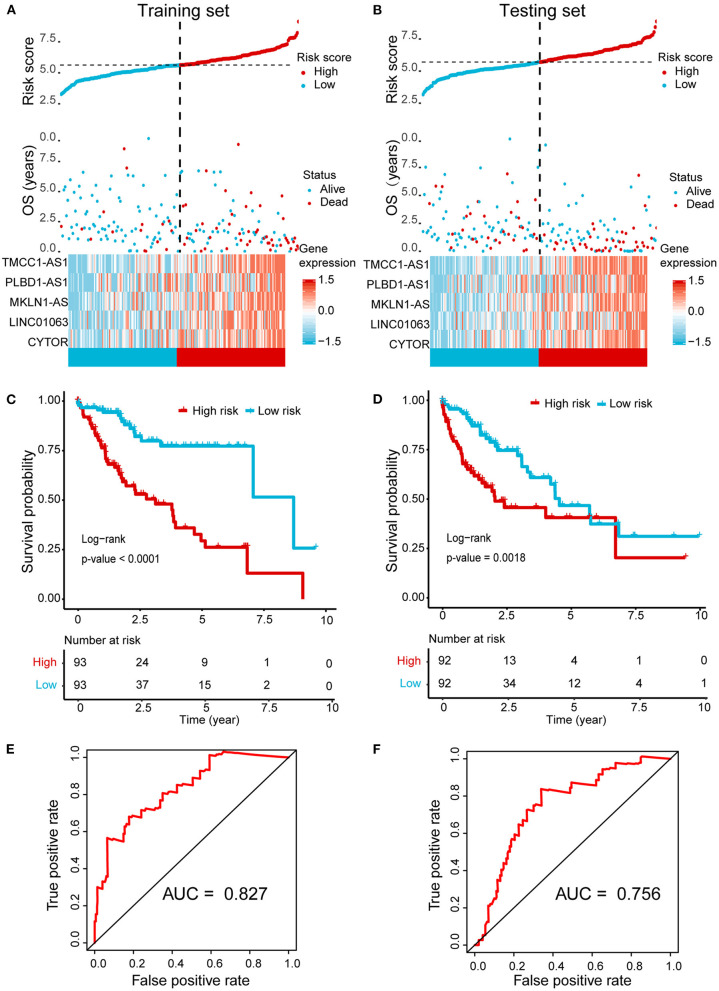
Establishment and validation of a five-AR-lncRNA prognostic signature for HCC survival prediction. Patients with a high or a low expression of the selected five AR lncRNAs have significantly different survival probability. (A,B) The distribution of risk score, survival state, and expression heatmap of the selected five AR lncRNAs in the training set (A) and testing set (B), respectively. (C,D) Kaplan–Meier survival curve for the high- and low-risk groups divided by the cutoff value in the training set (C) and testing set (D), respectively. p-values were obtained via log-rank test. (E,F) The receiver operating characteristic curve (ROC) for the prognosis prediction of the signature at 3 years of overall survival (OS) in the training set (E) and testing set (F), respectively.